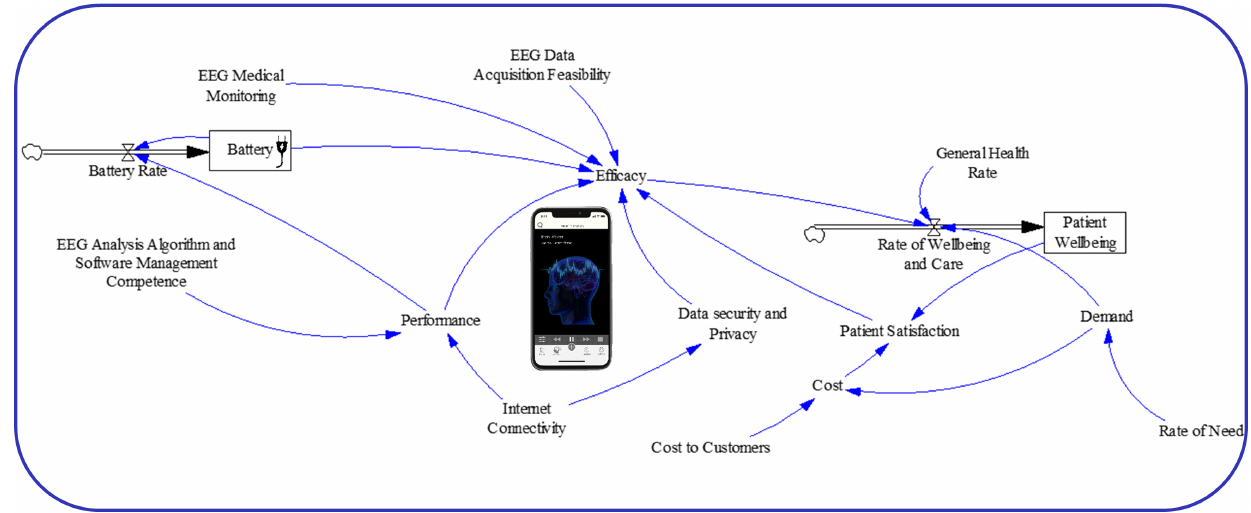
Figure 3. System dynamics model of EEG (Electroencephalography) monitoring